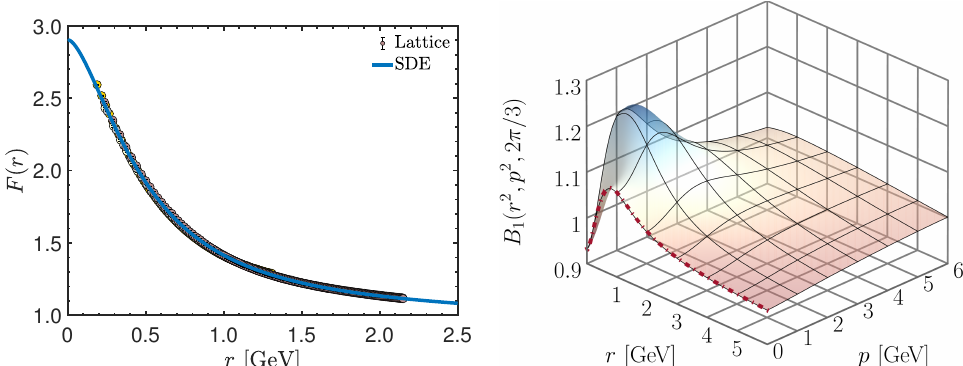
Figure 13. ( Left ): ghost dressing function F ( q ) obtained from the coupled system of SDEs of Equations (80) and (83) (blue continuous line) compared to the lattice data of Reference [73,85]. ( Right ): The corresponding result for B 1 ( r 2 , p 2 , θ ) for arbitrary magnitudes of the anti-ghost and gluon momenta, r and p , respectively, and a representative value of θ = 2 π /3 for the angle between them. The red dot-dashed curve highlights the soft gluon limit ( p = 0).